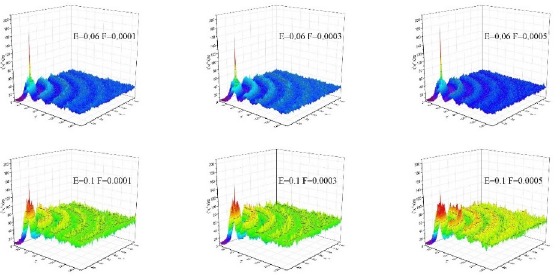
Fig 5. Examples of static structure factors of zero surface CD under different driving forces and electric field